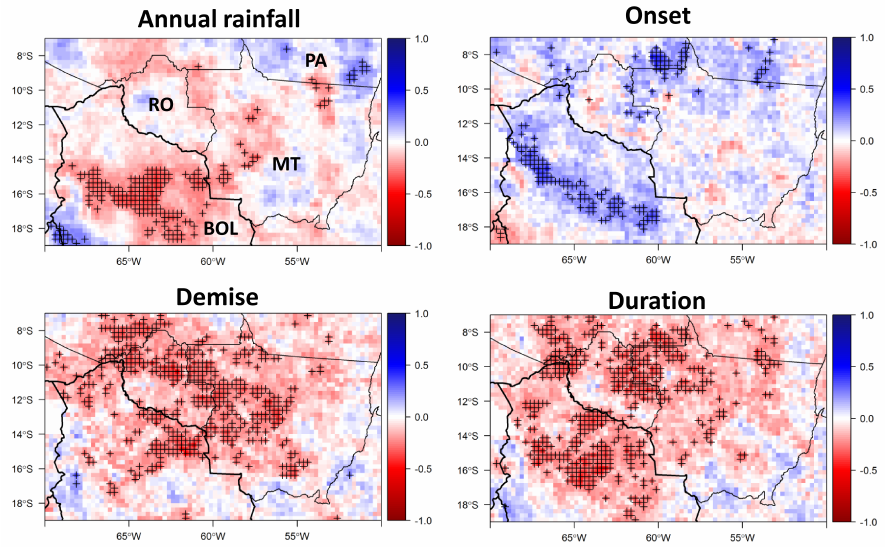
Figure 7. Trends in annual rainfall, onset date, demise date and duration of the rainy season in the southern Amazon estimated from PERSIANN-CDR for the 1983–2013 time period. The trends correspond to the τ of Mann–Kendall. Significant trends are indicated with crosses. Areas in white correspond to pixels where the rainy season is not well defined according to the Köppen classification rules. (PA = Pará, MT = Mato Grosso, RO = Rondônia, BOL =